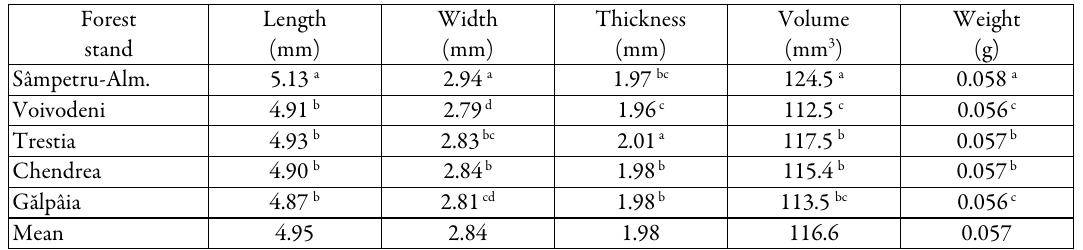
Table 3. Characteristics of the seeds harvested from R. pseudoacacia plus trees, depending on the origin